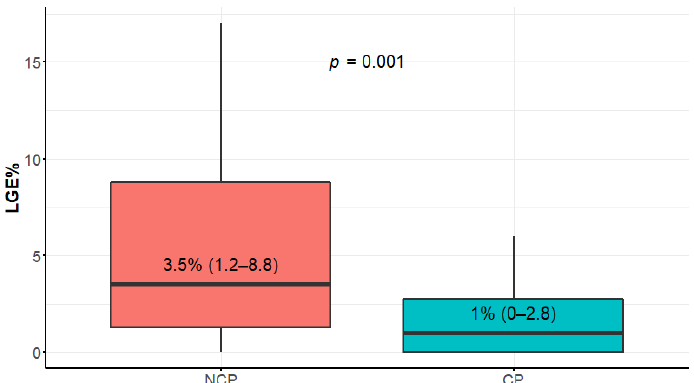
Figure 3. LGE (late gadolinium enhancement) extent comparison between nonclassic and classic phenotypes. Data presented in boxplot as median values, interquartile range, and minimal and maximal values.